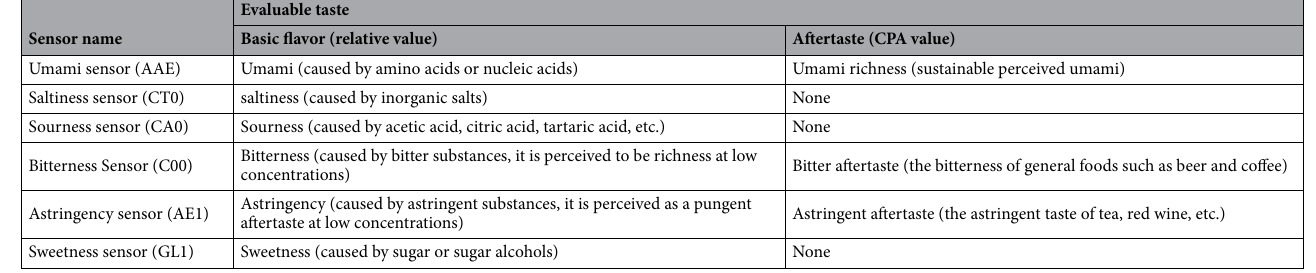
Table 2. Sensors of SA 402B electronic tongue and typical food